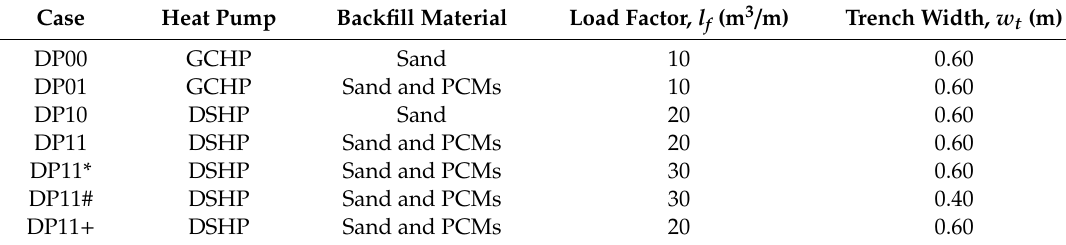
Table 2. Description of case